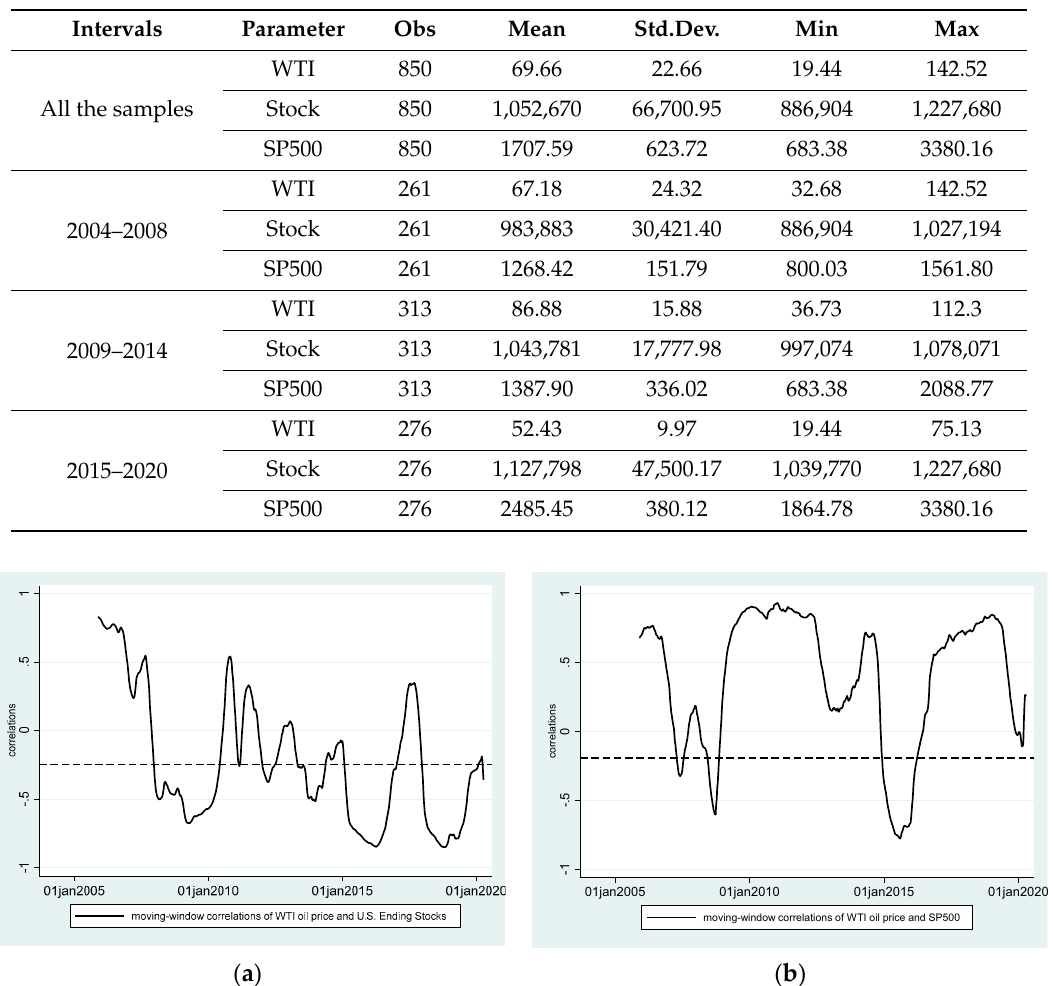
Table 1. Descriptive statistics of variables in di ff erent sample intervals.